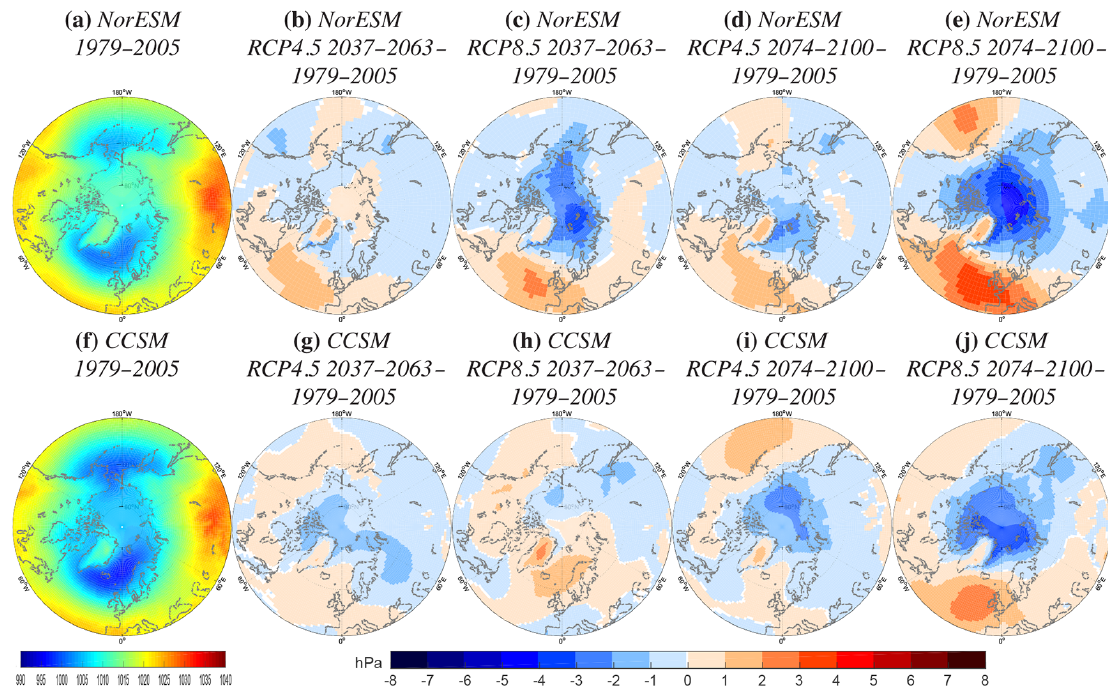
Figure 2. Sea level pressure (a, f) averages for SOND 1979–2005 and (b–e, g–j) changes in average over various time periods and scenarios compared to 1979–2005 in NorESM (upper row) and CCSM (lower row). The time periods and scenarios are (b, g) RCP4.5 2037–2063